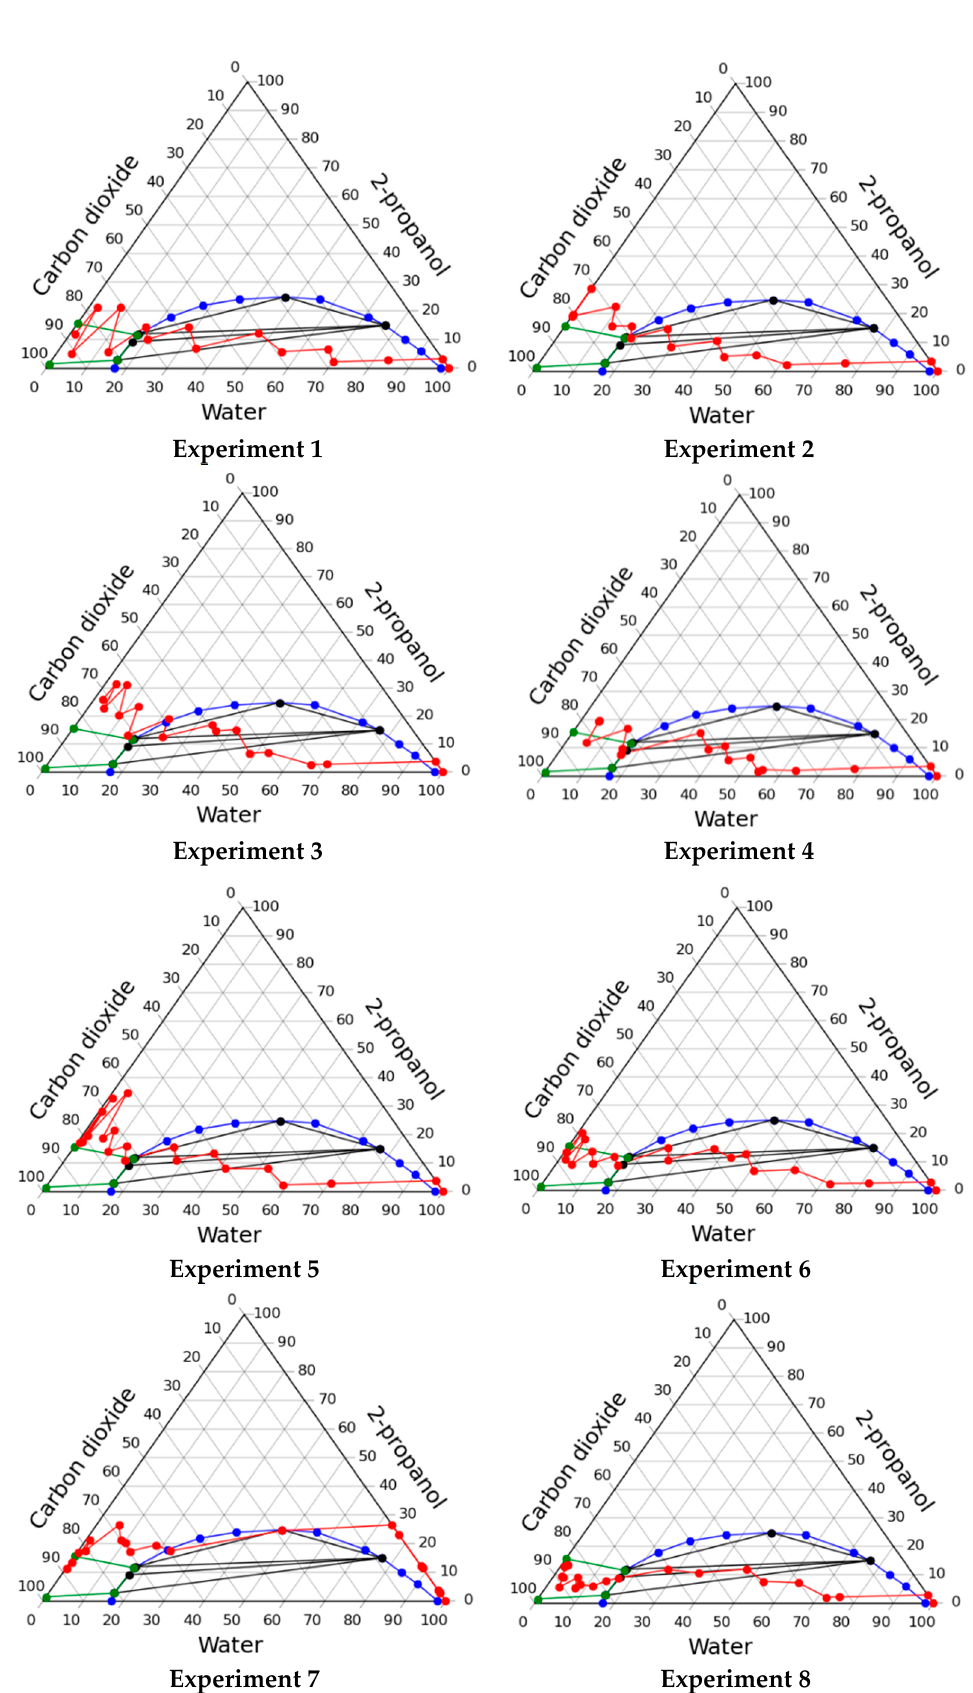
Figure 3. Operating lines of the solvent exchange process through multiphase region in various experiments.